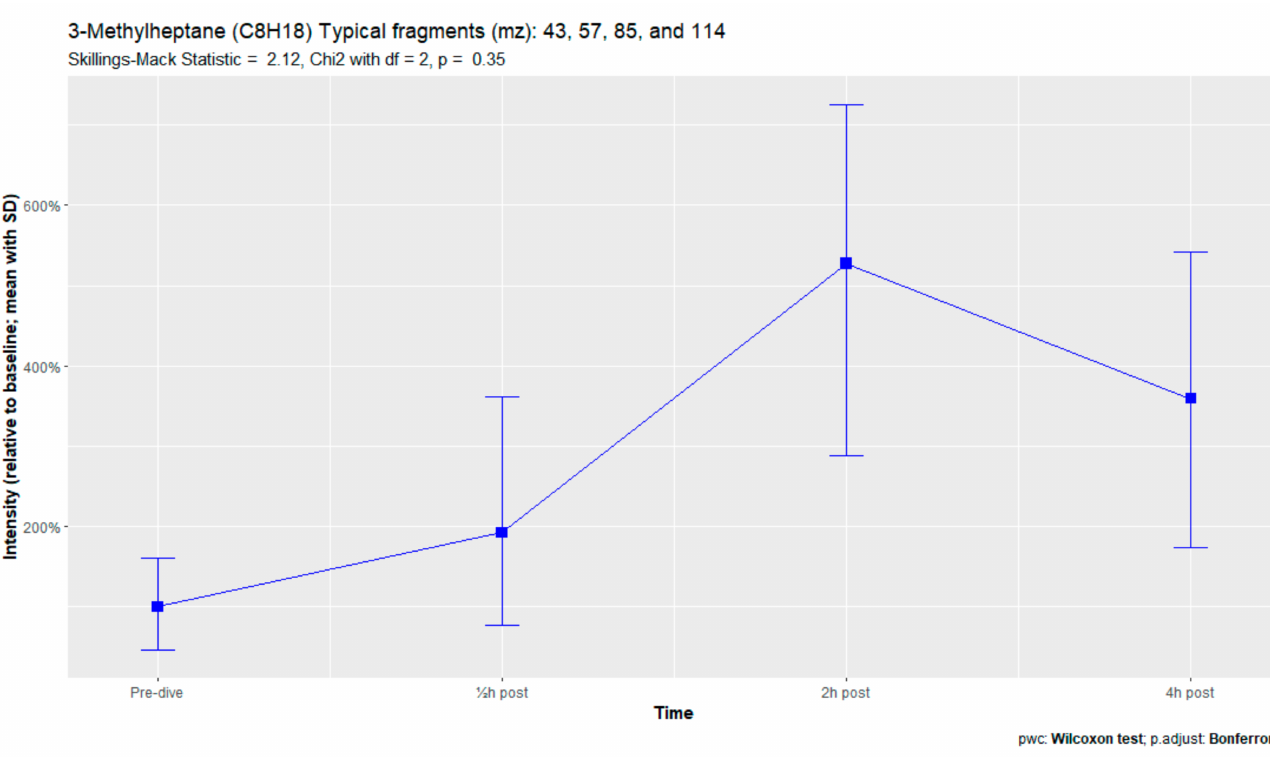
Figure A11. 3-Methylheptane.